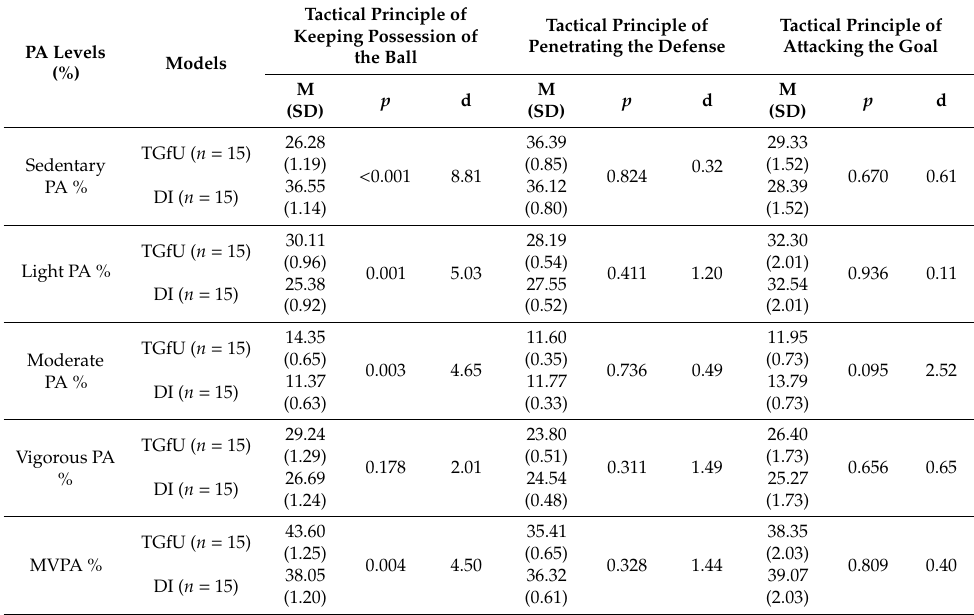
Table 4. Physical activity level according to attacking